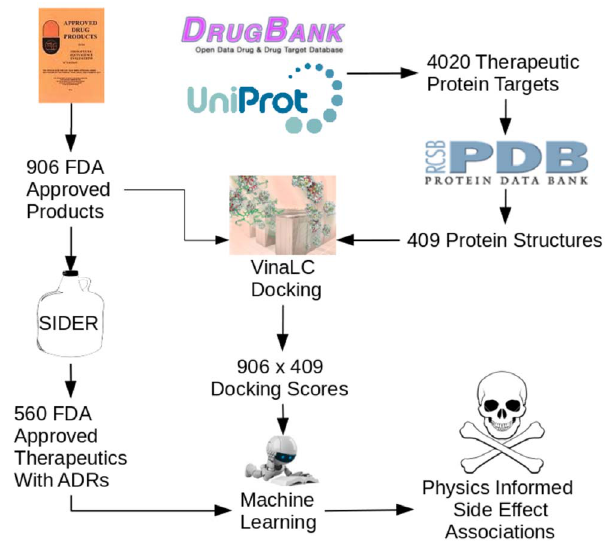
Figure 1. Data integration/analysis workflow scheme. The UniProt IDs of 4,020 proteins identified in DrugBank as drug targets were extracted. We obtained 409 experimental protein structures from the Protein Data Bank (PDB) to be used as a virtual panel and docked to 906 FDA-approved small molecule compounds using the VinaLC docking code, run on a high-performance computing machine at LLNL. 560 compounds had side effect information in the SIDER database and were used in subsequent statistical analysis to build logistic